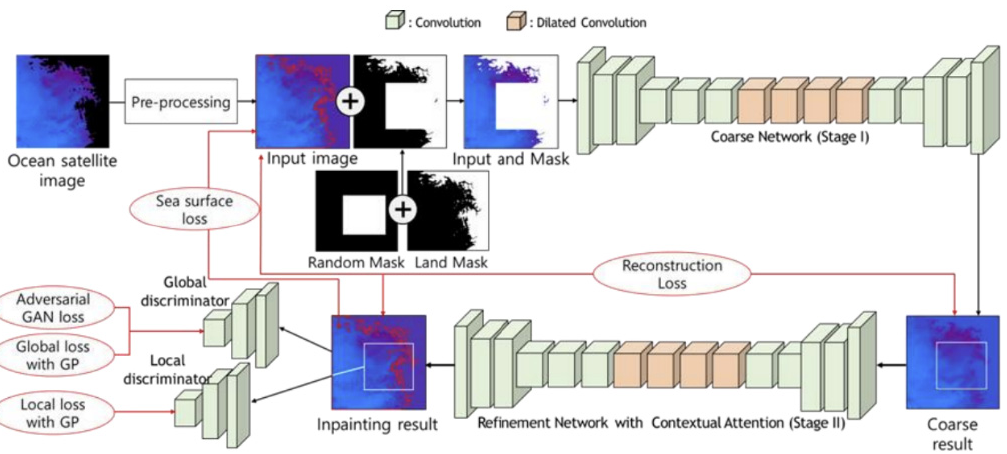
Figure 4. Structure of the GIN-based reconstruction method for satellite sea surface temperature data.